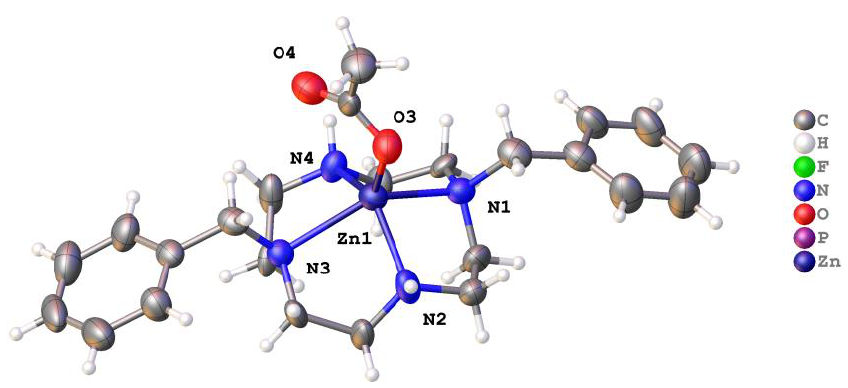
Figure 8. Molecular structure of [Zn( 1 )(OOCCH 3 )]PF 6 . Atoms are drawn as 50% probability ellip- soids. For clarity, disorder is not represented.